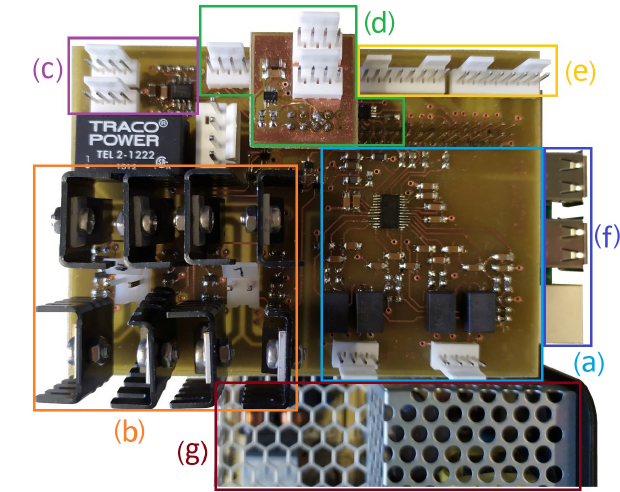
Figure 7. Custom-made evaluation board consisting of (a) a tem- perature measurement circuit, (b) H-bridges, (c) a fan control, (d) a voltage and current output, (e) connectors for stepper motors, (f) Raspberry Pi ports, and (g) power